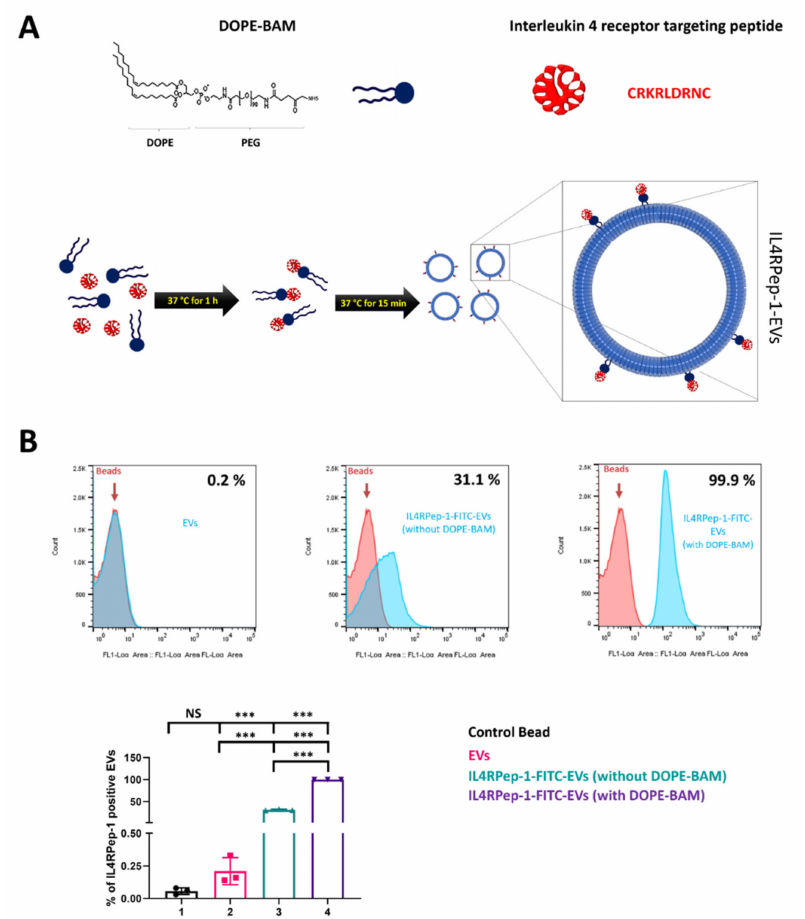
Figure 2. Labeling of extracellular vesicles with IL4RPep-1. ( A ) DOPE biological anchor for membrane (BAM), composed of dioleylphosphatidylethanolamine, methoxy polyethylene glycol (PEG), and succinyl-N-hydroxy-succinimidyl (NHS) ester conjugated with peptide and peptide complex, was inserted into the membranes of EVs. ( B ) Flow cytometry analysis of EVs and EVs labeled with IL4RPep-1-FITC in the presence and absence of DOPE-BAM complex. Percentage of EVs labeled with IL4RPep-1 is represented on a bar graph. Data are represented as means ± standard deviations (SD). Statistical differences between groups were analyzed using Student’s t -test. *** p <